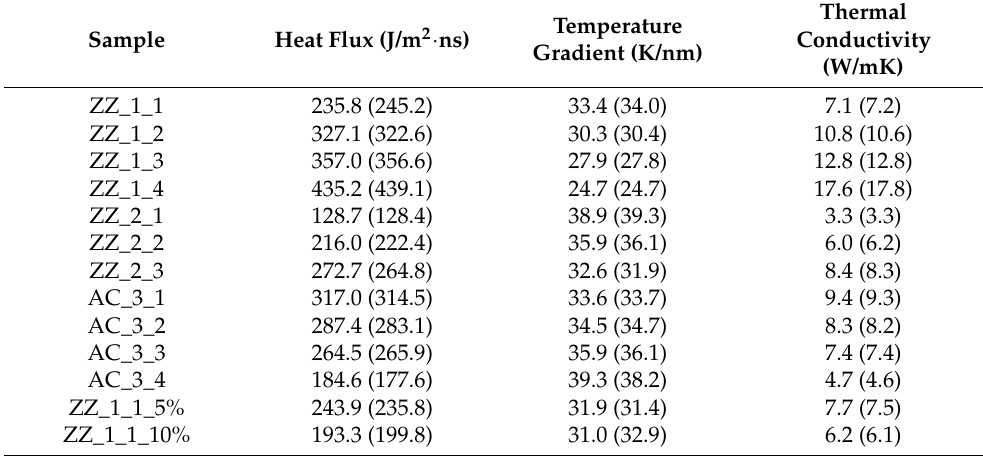
Table 2. Measured thermal conductivity of the monolayer GK. The values in parentheses were computed by exchanging the positions of two